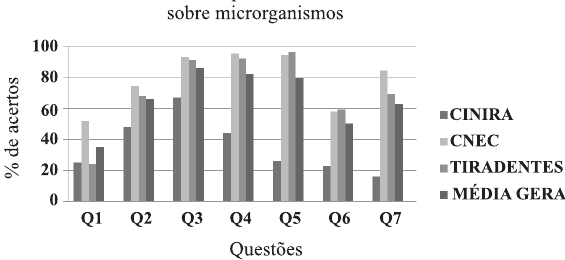
Figura 5. resultados do questionário sobre conhecimento específico dos microrganismos, aplicado a 272 estudantes das três